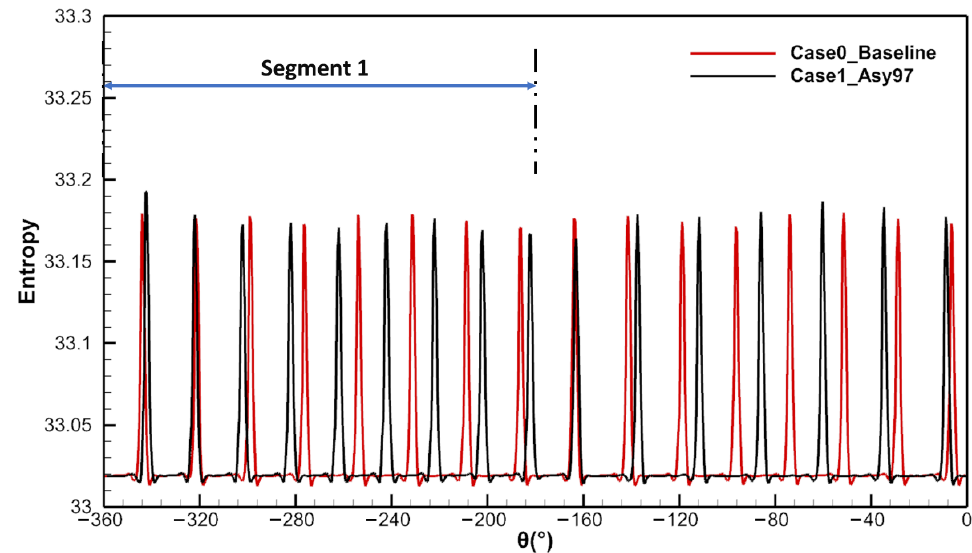
Figure 11. Circumferential distribution of the midspan entropy wakes at the vane exit. The nodal diameter (ND) component again indicates that the 16ND component of vane wakes in Case1_Asy97 (black line) was deconstructed and the energy was shifted to 14ND and 18ND with different entropy peaks. The 16ND component of vane wakes still had some spectral energy but its amplitude was reduced to an almost negligible value.